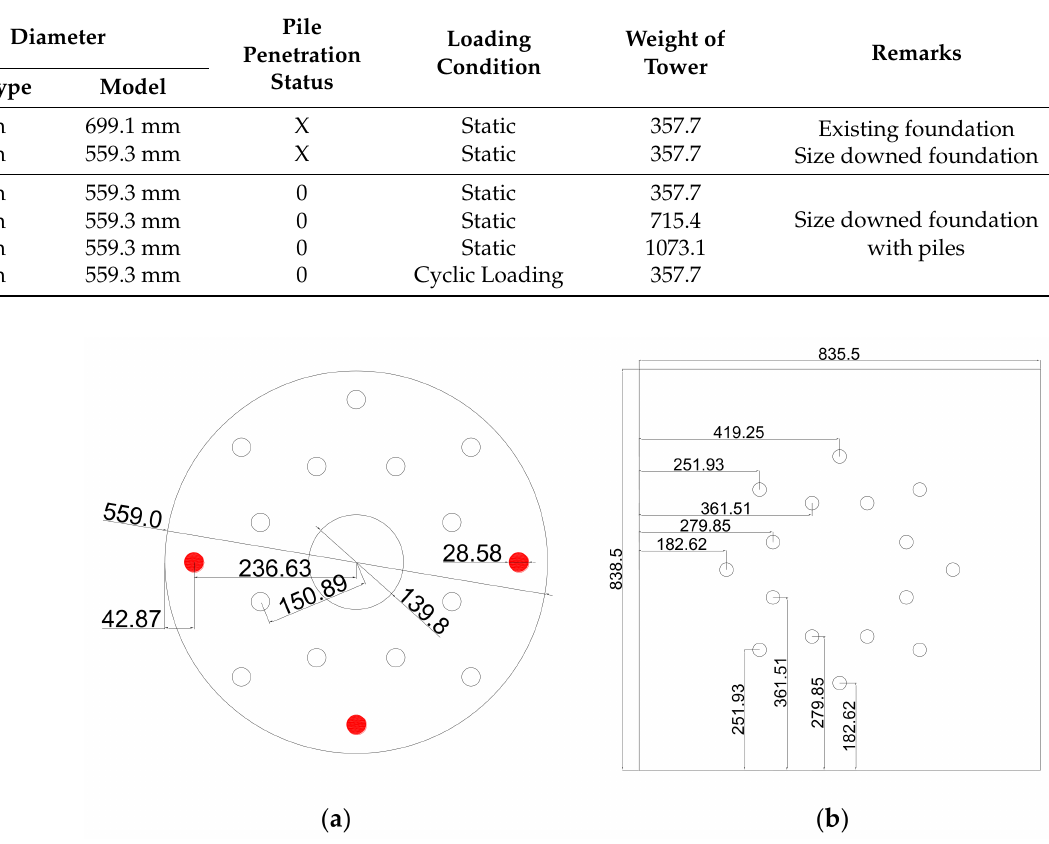
Figure 4. Location of piles: ( a ) foundation; ( b ) bedrock (unit: